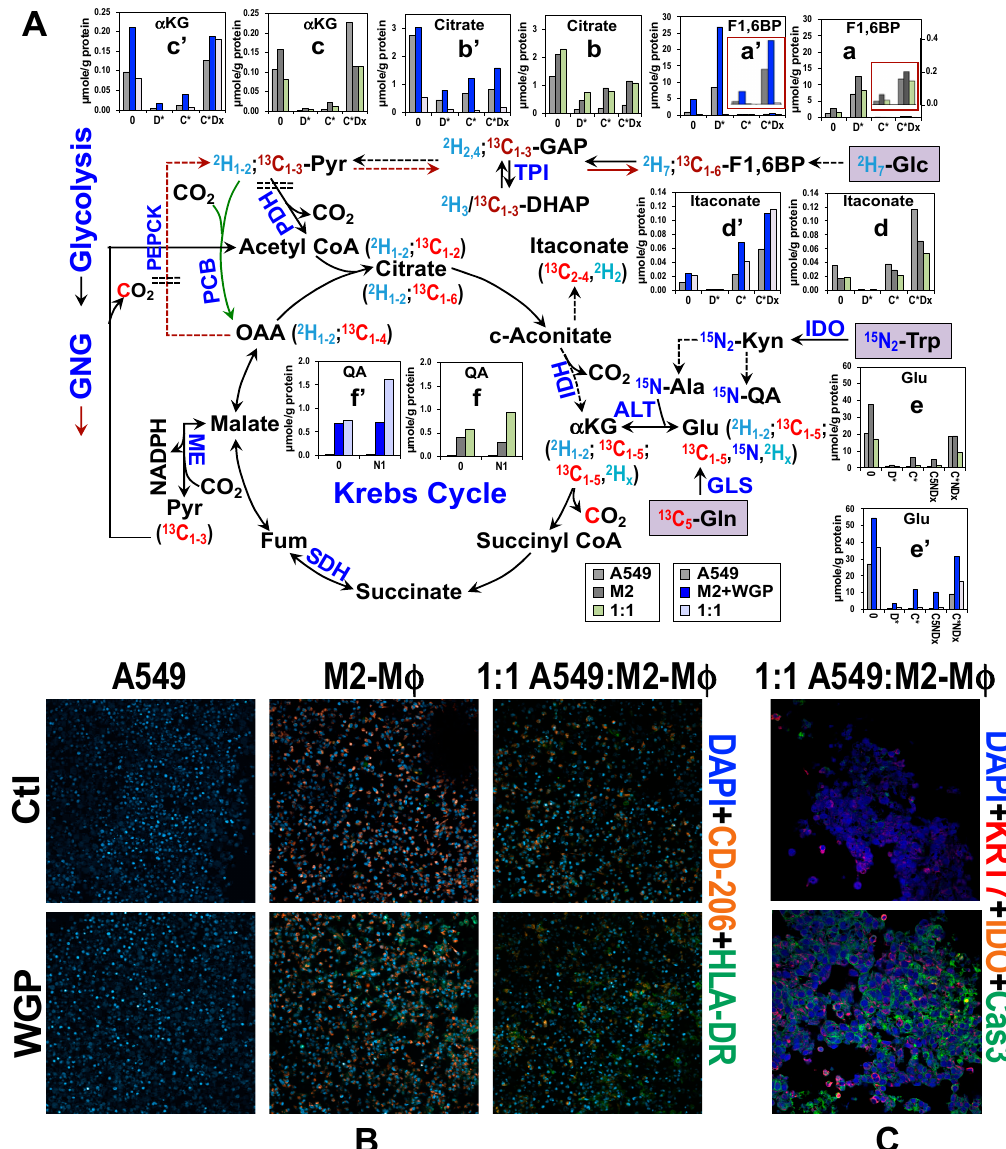
Figure 3. A549 cancer cell co-culturing alters metabolic and immune marker responses of human M2-M φ spheroids to WGP as tracked by mSIRM. The 3D single or co-cultures (1:1 A549:M φ ) (n = 2) in ( A ) were treated with IL-4+IL-13 for 3 d ± WGP as in Figure 2 except with 2H7-Glc+13C5-Gln+15N2-Trp as tracers in the last 24 h. The cell extracts were combined for IC-UHR-FTMS analysis. 2H/13C/15N atom tracing through glycolysis, the Krebs cycle, GNG, and Trp catabolism is shown to account for some of the labeled isotopologues of metabolites seen by IC-UHR-FTICRMS analysis. Red boxes denote 13C labeled fructose-1,6-bisphosphate (F1,6BP) produced by the GNG pathway. ∎ : A549; ∎ : M2-M φ ; ∎ :A549:M2-M φ 1:1; ∎ : M2+WGP; ∎ : A549:M2-M φ 1:1+WGP; D*: total 2H; C*: total 13C; N: 15N; Cx: 13Cx; Dx: 2H0-x; GAP: glyceraldehyde-3-phosphate; DHAP: dihydroxyacetone-3-phpsphate; Pyr: pyruvate; α KG: α ketoglutarate; Fum: fumarate; OAA: oxaloacetate; Kyn: kynurenine; QA: quinolinate; TPI: triosephosphate isomerase; PDH: pyruvate dehydrogenase; PCB: pyruvate carboxylase; ALT: alanine transaminase; SDH: succinate dehydrogenase; ME: malic enzyme; PEPCK: phosphoenolpyruvate carboxykinase; IDO: indoleamine 2,3-dioxygenase; GLS: glutaminase. In ( B ), treated mono- and co-cultures were stained as live cells for M2 (CD-206), M1 (HLA-DR), and nuclear (DAPI) markers while in ( C ), cells were fixed in 4% paraformaldehyde before staining for cancer cell (KRT7), M1 (IDO1), and apoptotic caspase 3 (Cas3) markers.